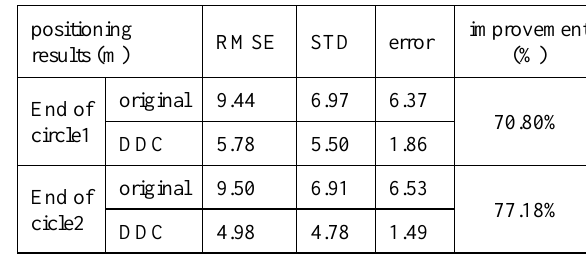
Table 2. The error of BLE positioning result of participant